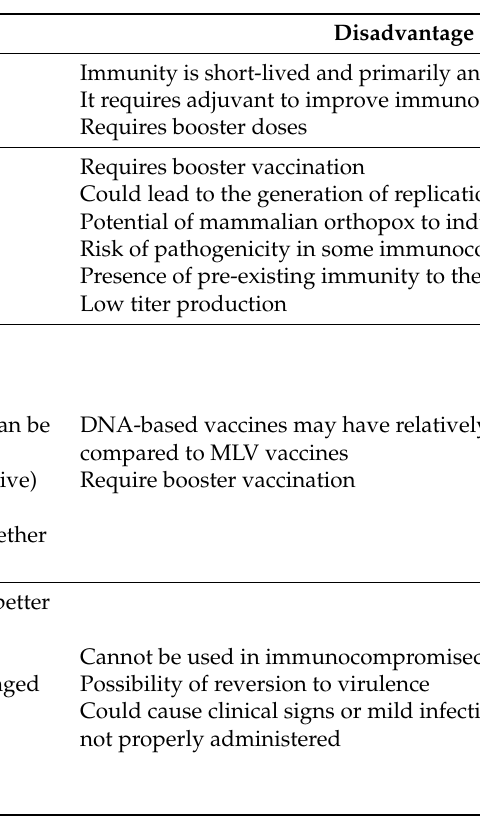
Table 4. Advantages and disadvantages of different EI vaccine technologies compared to conventional inactivated-virus